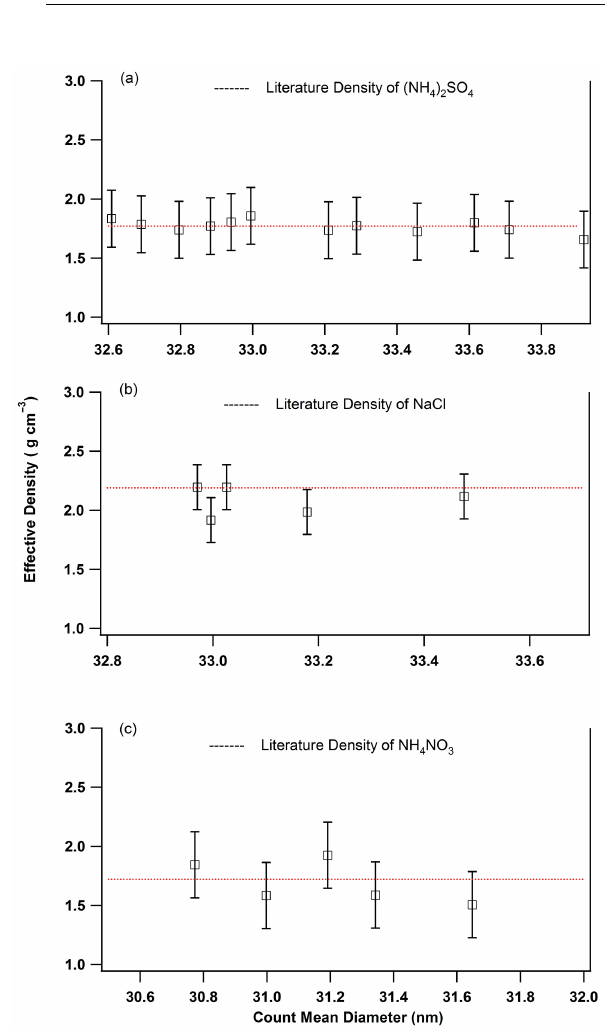
Figure 3. Laboratory-generated inorganic salt particle effective density versus count mean diameter over the size range 10–478nm: (a) ammonium sulfate, (b) sodium chloride and (c) ammonium ni-